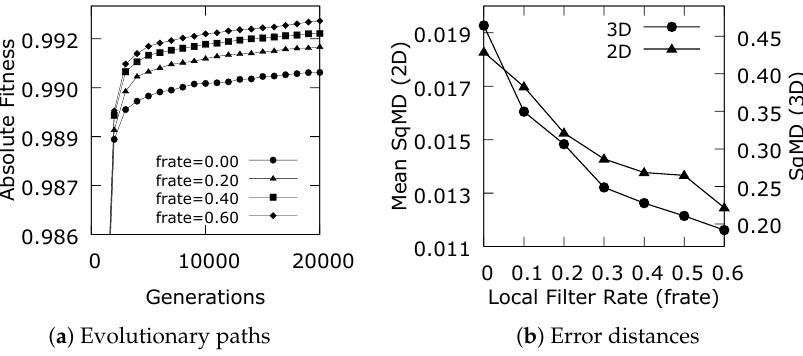
Figure 7. Effect of the filter rate (frate), Gaussian profile